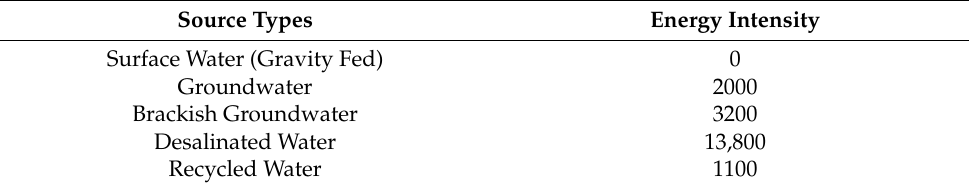
Table 3. Generic energy intensity of water supply types